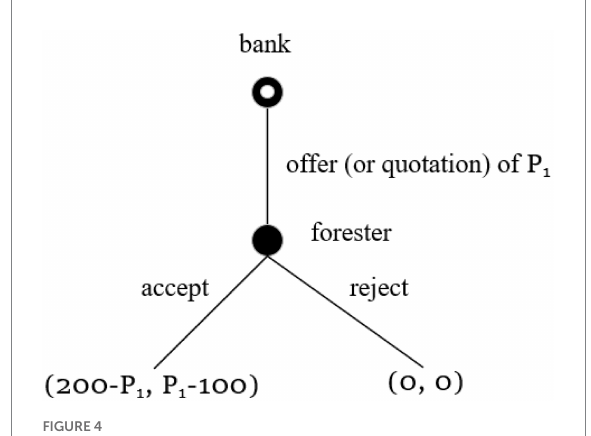
FIGURE 4 A bargaining game in “one-price”